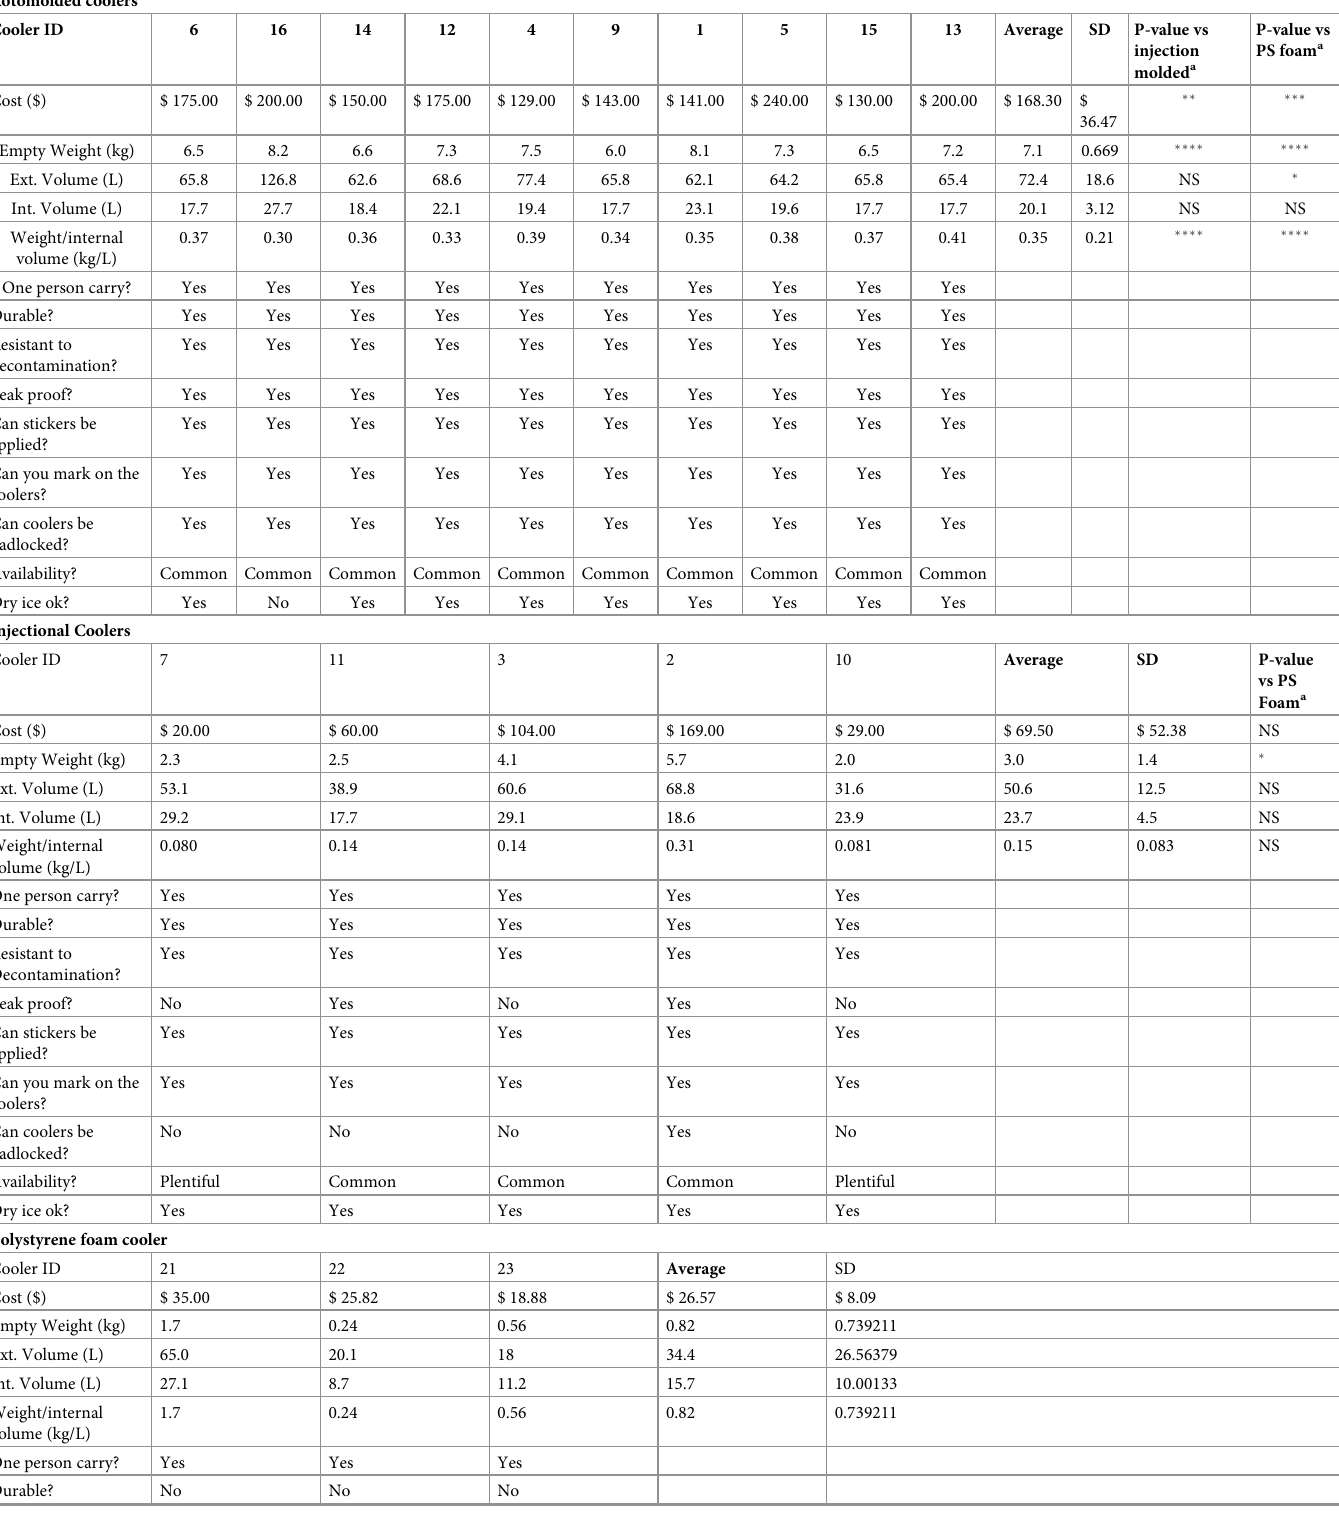
Table 1. Description of coolers used in